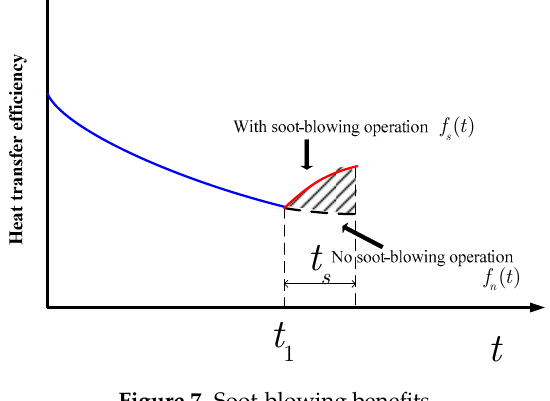
Figure 7. Soot-blowing Figure 7. Soot ‐ blowing benefits.